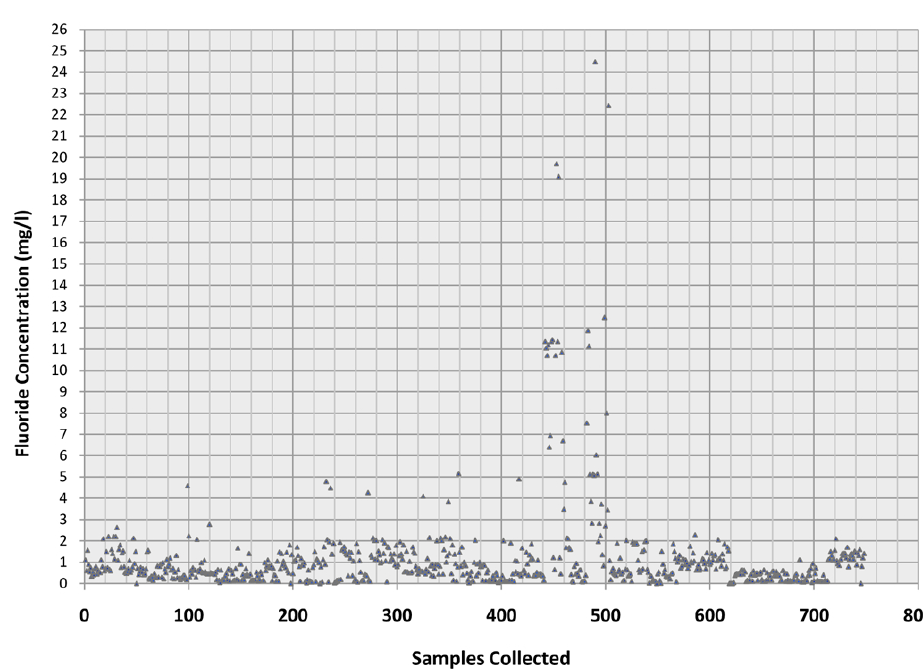
Figure 2. Variation of fluoride concentration (mgL − 1 ) in the monitored sites.